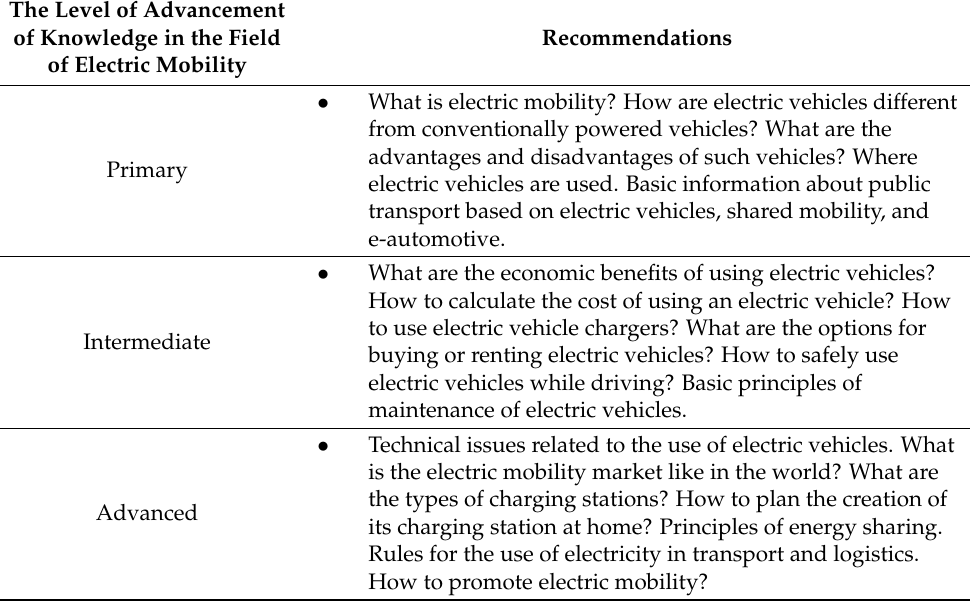
Table 4. Expert recommendations regarding knowledge in the field of electric mobility at various levels of